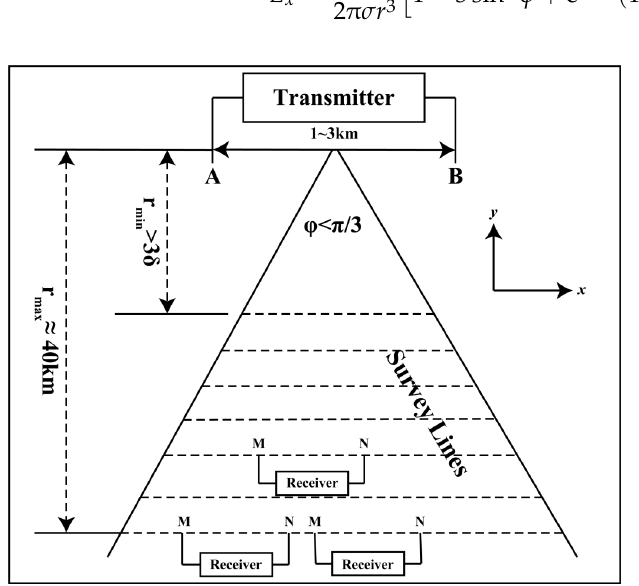
Figure 3. Schematic diagram of the WFEM arrangement, modified from [29].